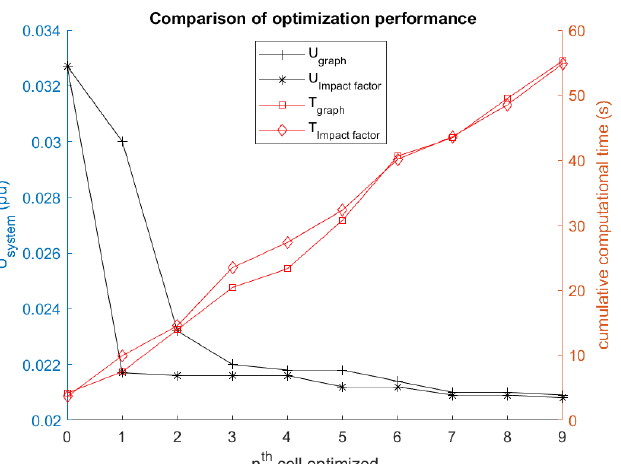
Figure 12. Comparison of voltage of three randomly selected nodes across the optimized one minute time frame.